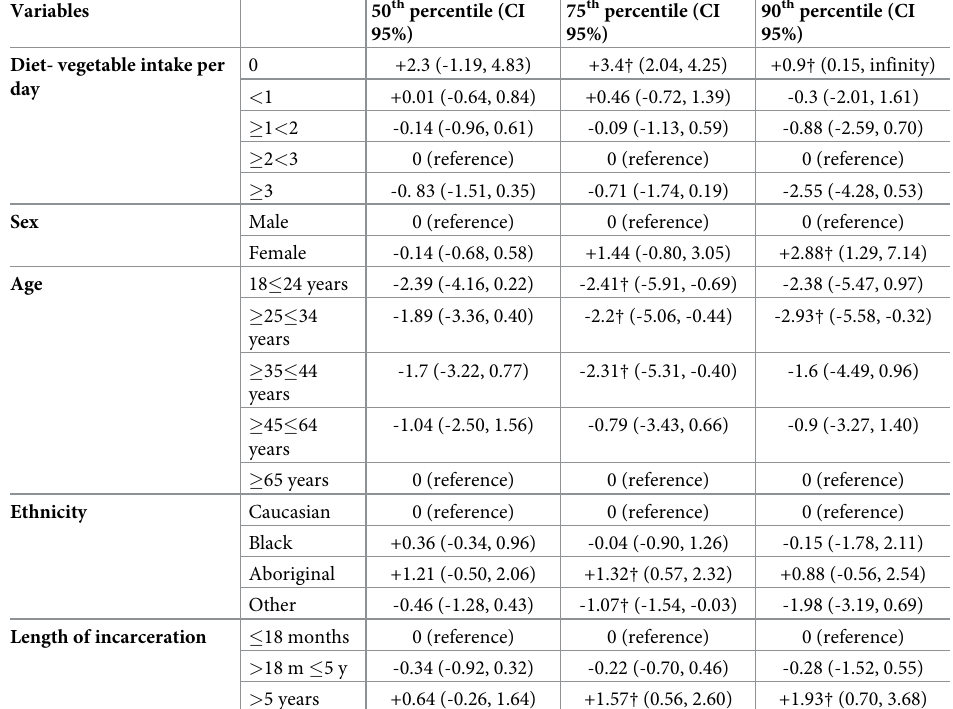
Table 6. Quantile regression coefficients analysis for estimated BMI change based on the daily frequency of vege- table intake and sociodemographic factors and length of incarceration.